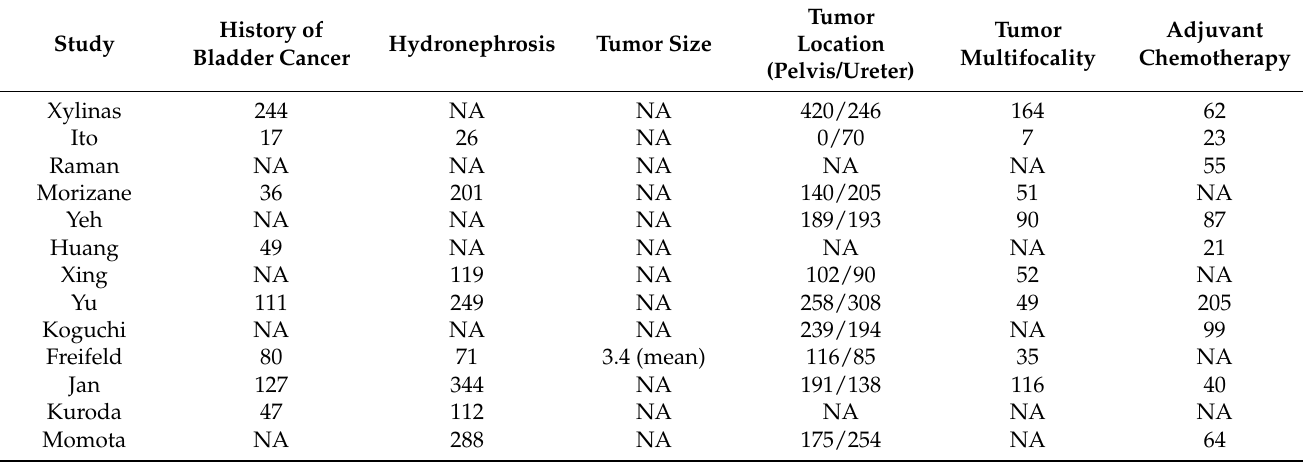
Table 3. Tumor characteristics of the eligible studies.